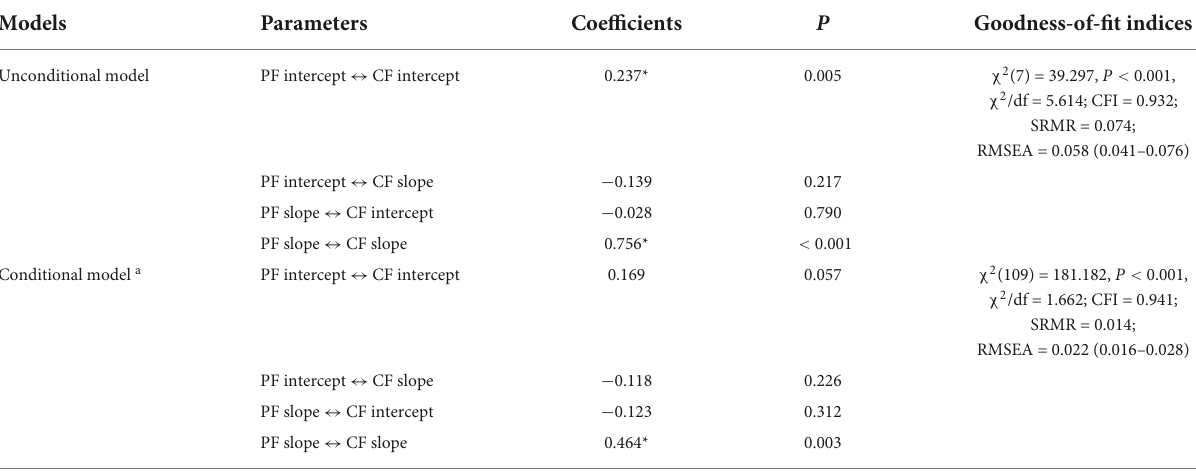
TABLE 3 Standardized coefficients for parallel process